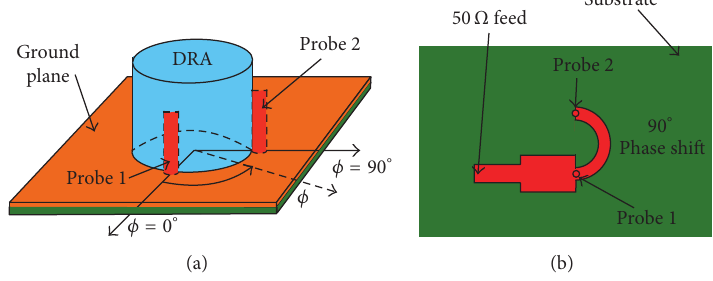
Figure 17: Circularly polarized dual-fed cylindrical DRA as suggested in [31].